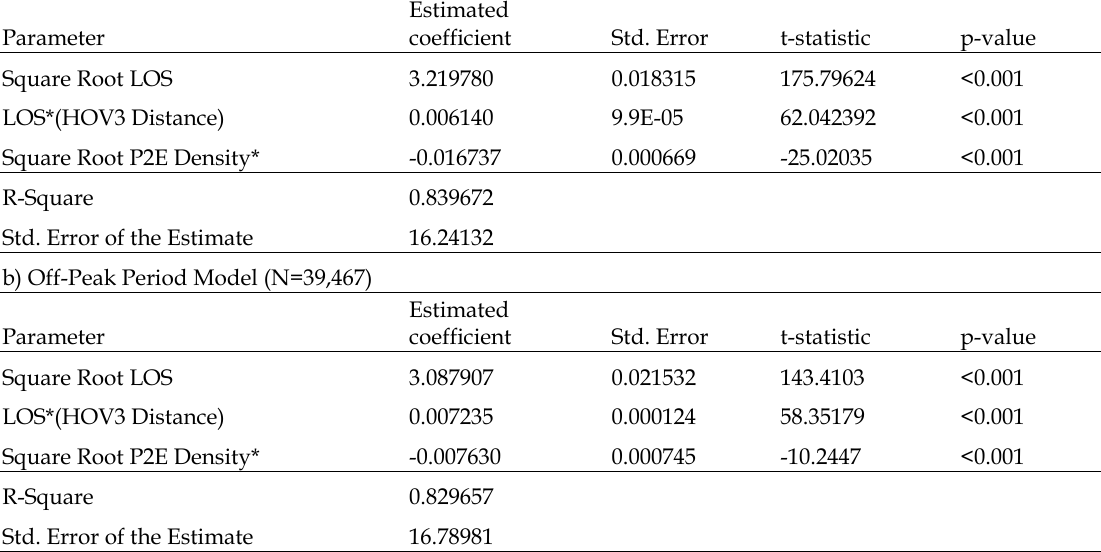
Table 2: Out Vehicle Time (OVT) Functions for (a) Peak and (b) Off Peak